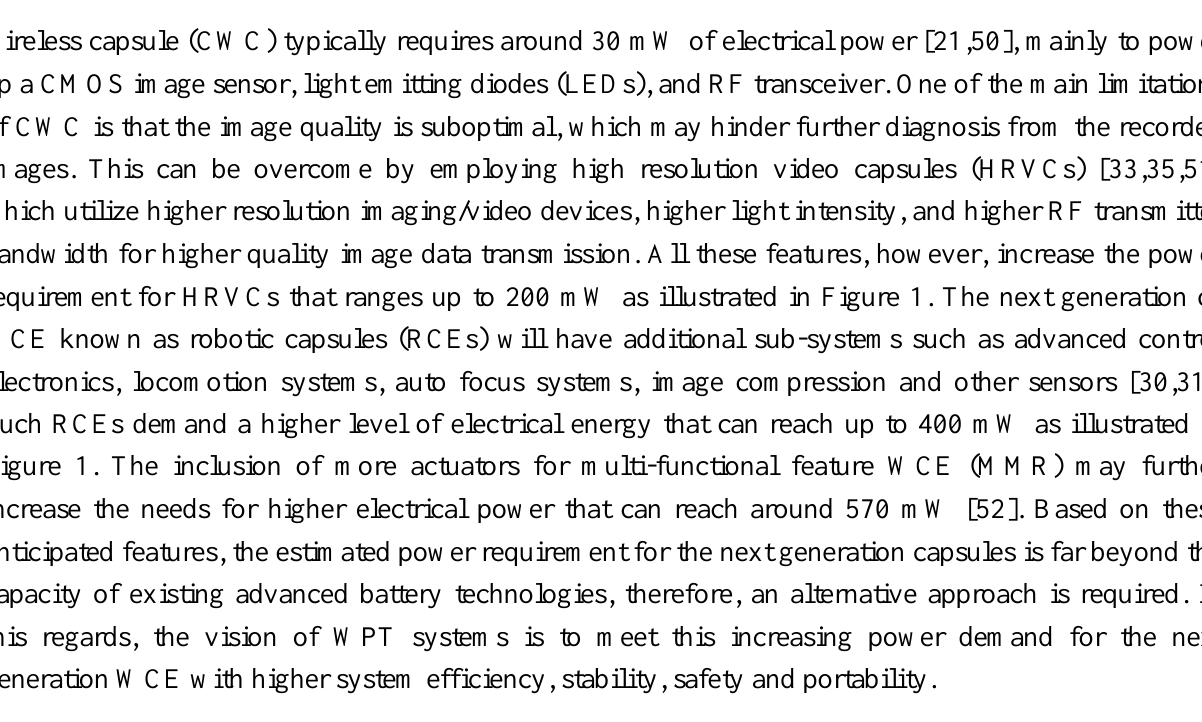
Figure 1. Power requirement for different types of WCE